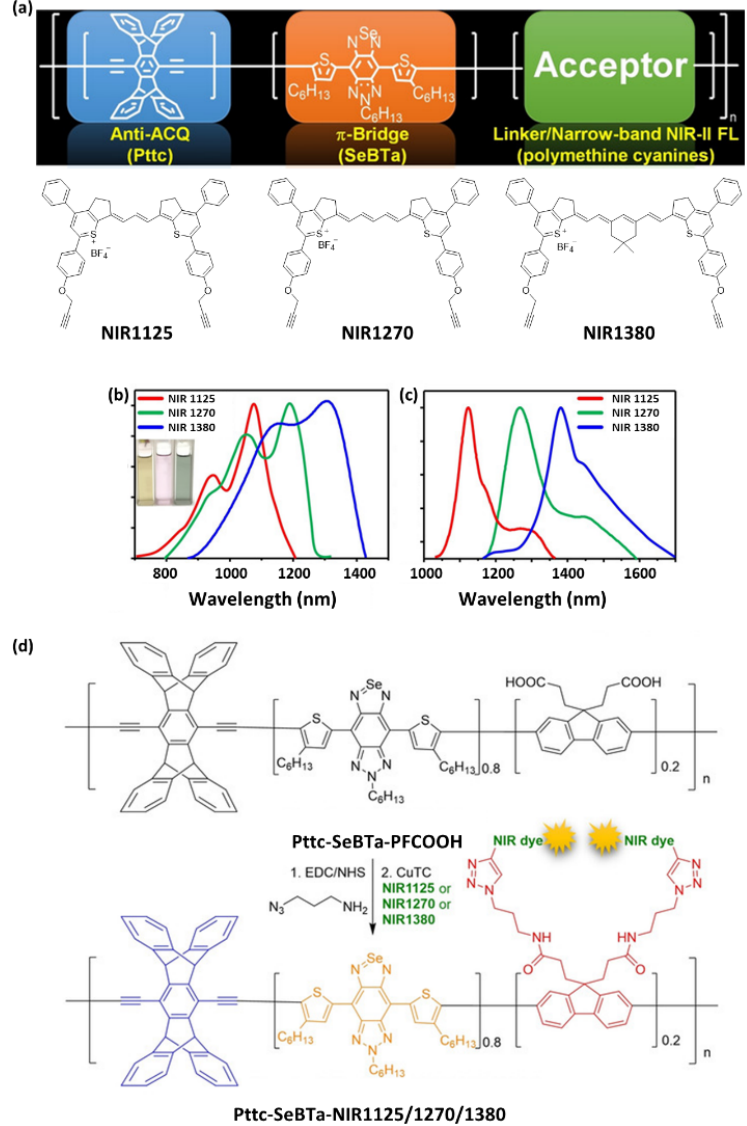
Figure 17. ( a ) Chemical structures of polymethine dye-conjugated semiconducting polymers. Three types of NIR-II fluorescent polymethine dyes (NIR1125, NIR1270, and NIR1380) were synthesized with activable alkyne functional groups for further conjugation with the semiconducting polymer. ( b ) Absorption spectra of NIR1125 (red line), NIR1270 (green line), and NIR1380 (blue line) in CH 2 Cl 2 . The middle-left inset shows a photograph of the dye solutions. ( c ) Emission spectra of NIR1125 (red line), NIR1270 (green line), and NIR1380 (blue line) in CH 2 Cl 2 . ( d ) Synthesis of a semiconducting polymer bearing carboxylic acid groups for further transformation to azide groups, followed by CuAAC click reactions with polymethine dyes. Reprinted with permission from Ref. [8]. Copyright 2020, John Wiley and Sons.